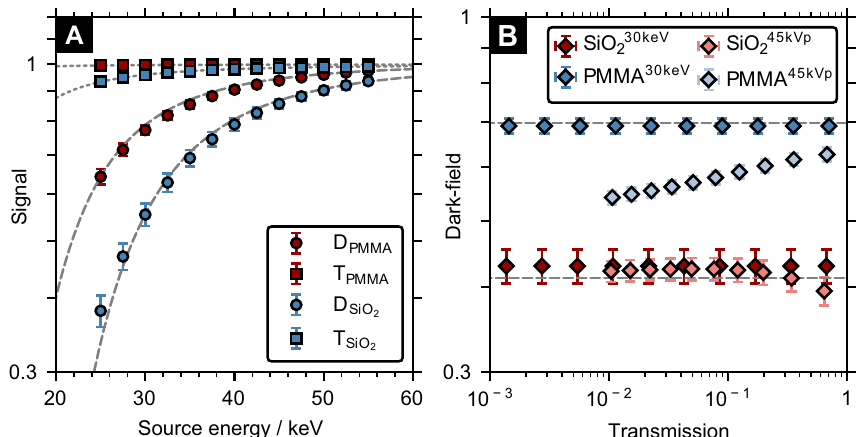
Figure 5. Influence of the source energy on the dark-field signal. ( A ) Semi-logarithmic plot of the dark-field (D) and transmission (T) signals’ dependence on the source energy for a cubic sample containing an ensemble of glass (SiO 2 ) or PMMA spheres ( f = 0.05 , t = 3 mm and d = 3 µ m ). ( B ) Two-dimensional histogram plot showing the correlation of the dark-field and transmission signals for an increasing thickness ( 0.01 mm to 0.19 mm ) of lead between the diffuser and sample ( f = 0.05 , t = 4 mm and d = 2 µ m ). A monochromatic 30 keV source (dashed gray lines indicate the theoretical dark-field signals calculated according to Eq. (5)) and a 45 kVp spectrum were